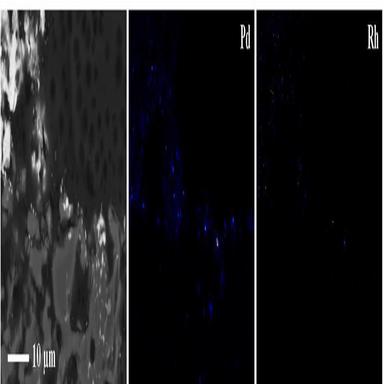
EPMA–WDS map of Pd and Rh from the view near the cordierite support in C1.